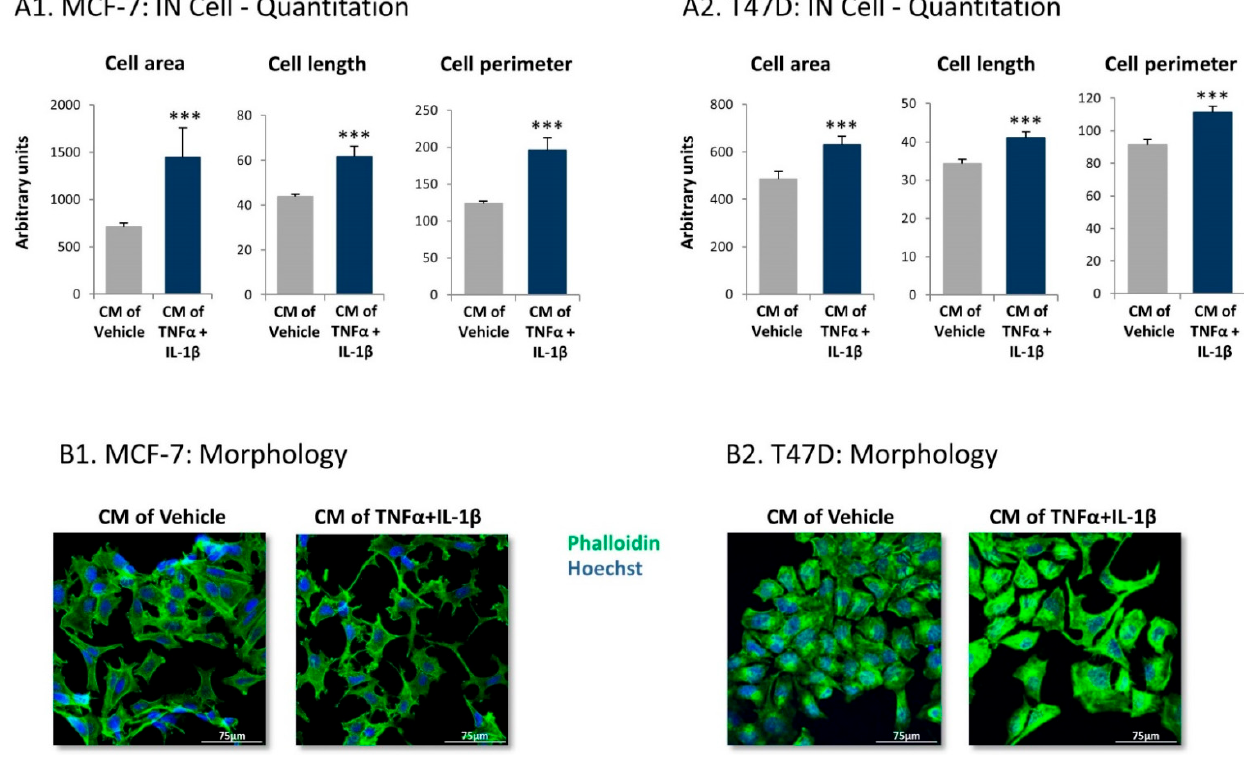
Figure 7. Following persistent stimulation of MSCs with TNF α + IL-1 β , the resulting inflammatory CAFs release factors that induce morphological changes in luminal-A breast cancers (BC) cells. Human MSCs were exposed to persistent TNF α + IL-1 β stimulation (concentrations as in Figure 1) or to vehicles, generally for 14–18 days. At the end of the stimulation period, cytokines were replaced by fresh cytokine-devoid media, and 48 h later, conditioned media (CM) were collected and administered to human luminal-A BC cells. ( A ) Tumor cell characteristics were quantified 4 days or 3 days after the addition of CM to MCF-7 cells ( A1 ) and to T47D cells, repectively ( A2 ) by IN Cell technology. The results of a representative experiment out of n = 3 are presented. *** p < 0.001. ( B ) Tumor cell morphology was photographed by confocal microscopy 2–3 days after the addition of CM, using phalloidin staining of actin filaments (green) and Hoechst staining of nuclei (blue). ( B1 ) MCF-7 cells. ( B2 ) T47D cells. Images from a representative experiment out of n = 3 are presented. Bar, 75 μ m.